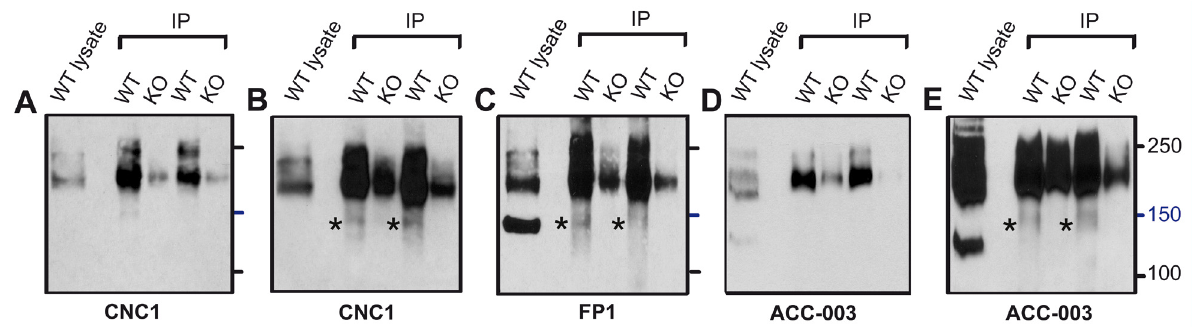
Figure 6. Differential recognition of the strong 150 kDa FP1 band in lysate and weak 150 kDa band by FP1, CNC1, and ACC-003 after IP of α 1.2 with FP1. Immunoblots with CNC1 ( A , B ), FP1 ( C ), and ACC-003 ( D , E ) of Triton X-100 extracts from WT mice (lysate) and 1 after immunoprecipitation with FP1 from cKO and WT mice. Gels were polymerized from 8% acrylamide. Note that a weak 150 kDa band is detected by CNC1, FP1, and ACC-003 after enrichment of α 1.2 by immunoprecipitation with FP1 but the strongly immunoreactive 150 kDa 1 band detected by FP1 in lysate is not detectable by either CNC1 or